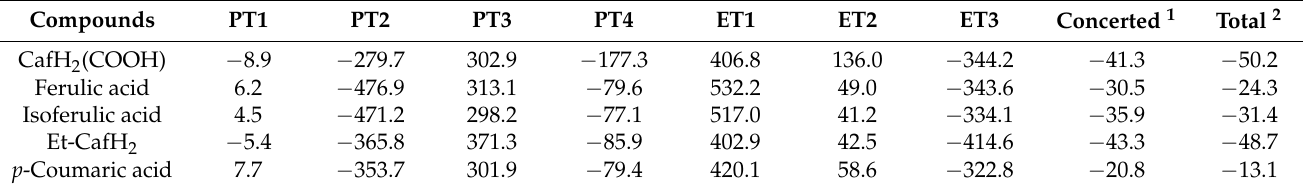
Table 1. Δ G °s (kJ mol − 1 , 298.15 K) of PCET between O 2• − and HCAs (CafH 2 (COOH), ferulic acid, isoferulic acid, Et-CafH 2 , and p -coumaric acid) in DMF, calculated using DFT at the